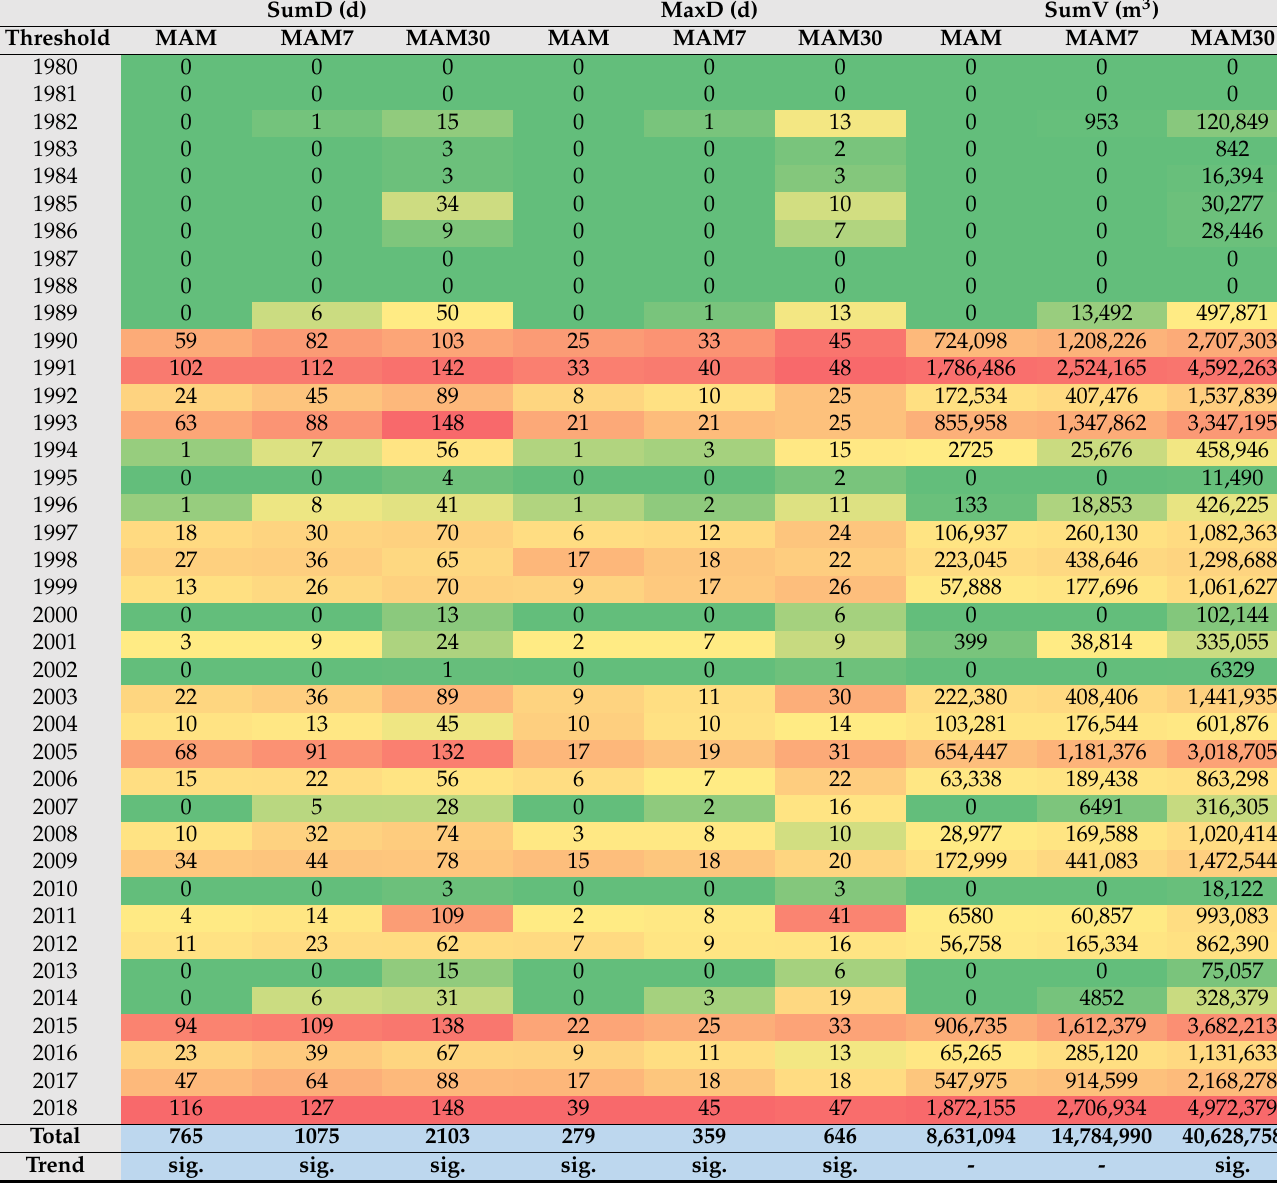
Table 7. Characteristic values GER out